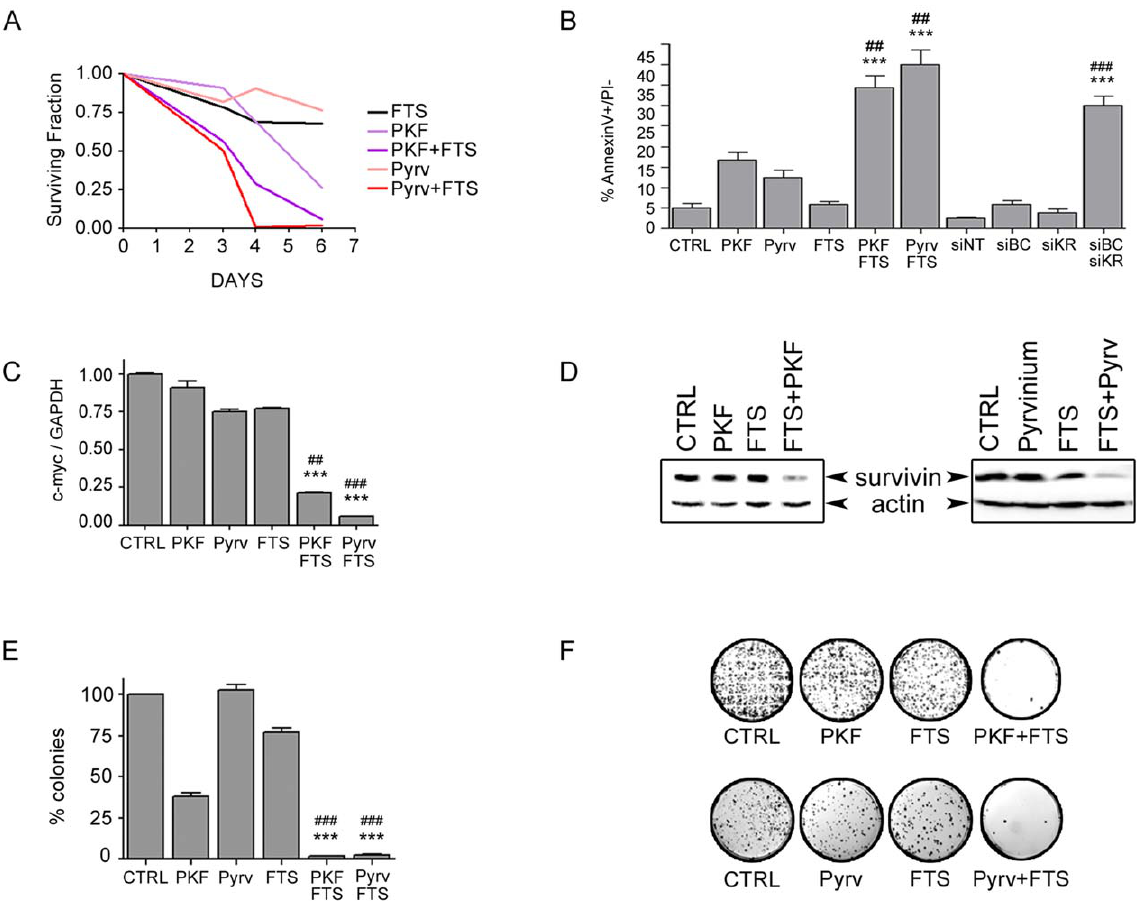
Figure 3. Characterization of synergism in Ls174T cells. ( A ) Cells were treated with 100 m M FTS, 0.25 m M PKF115-584 or 50 nM pyrvinium, alone or in combinations, or vehicle, for 6 days. Cell culture viability was assessed on days 3, 4 and 6 by MTS. The relative OD compared to vehicle- treated control cells was recorded as surviving fraction. ( B ) Ls174T cells were cultured for 3 days in the presence of the indicated compounds (same concentrations as in [ A ]); in parallel, Ls174T cells carrying inducible siRNAs (siNT, non-targeting; siBC, anti- b -catenin; siKR, anti-KRAS) were treated with doxycycline for the same time. Apoptosis was determined by annexin V/propidium iodide double staining. The percentage of early apoptotic cells (annexin V-positive/propidium iodide-negative) is reported in the graph. ( C ) Ls174T cells were treated with PKF115-584 (0.5 m M), pyrvinium (50 nM) and FTS (100 m M), alone or in combination, for 24 hours and c-myc expression was evaluated by real-time PCR using GAPDH as a reference gene. Expression was normalized on vehicle-treated control cells. ( D ) The cells were incubated for 72 hours with inhibitors and cell lysates probed with anti-survivin and b -actin antibodies. ( E–F ) Ten thousand Ls174T cells were grown in soft-agar in the presence of PKF115-584 (0.1 m M), pyrvinium (25 nM), FTS (50 m M), alone or combined. Large colonies were counted 20 days later. The number of colonies formed by untreated control cells is set as 100% ( E ). Representative photographs are shown in panel ( F ). Statistical analysis: see legend to figure 2. doi:10.1371/journal.pone.0051449.g003 PLOS ONE |